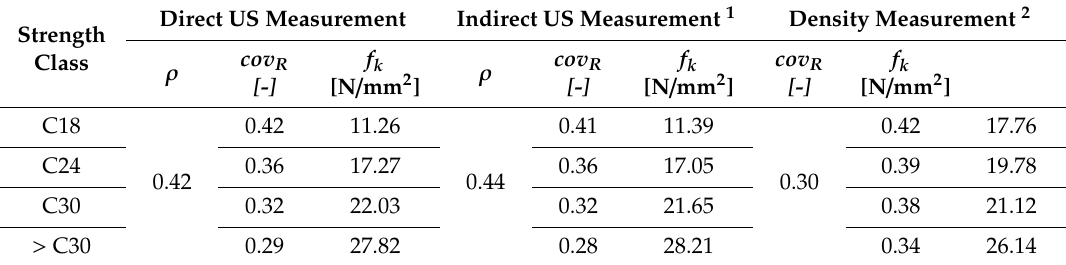
Table 3. Results for spruce samples and different grading techniques obtained from the stochastic grading model.